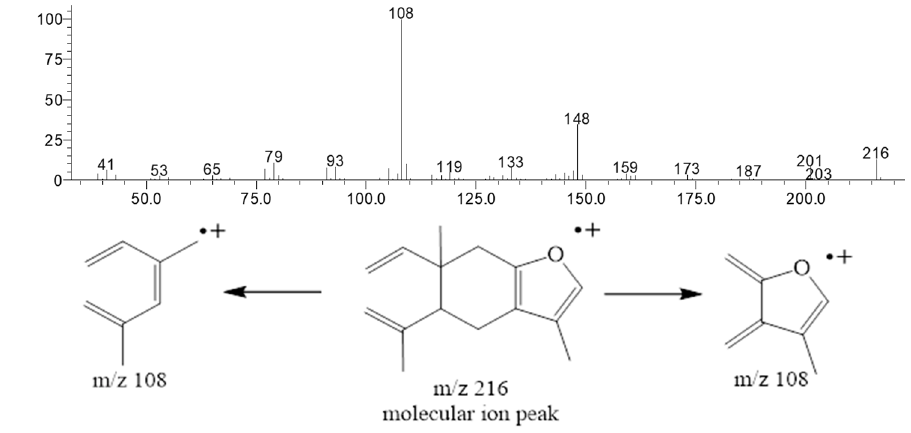
Figure 3. Curzerene mass spectrum and its base-peak fragmentation (108 m / z ).